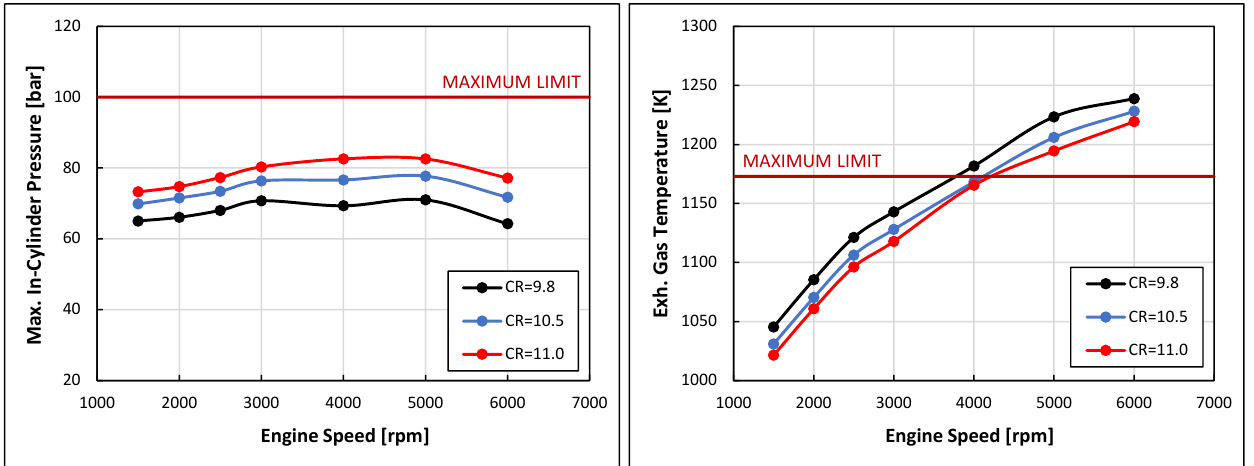
Figure 14. Maximum in-cylinder pressure ( left ) and exhaust gas temperature ( right ) for different compression ratios. ϕ = 1, WOT, no boost.